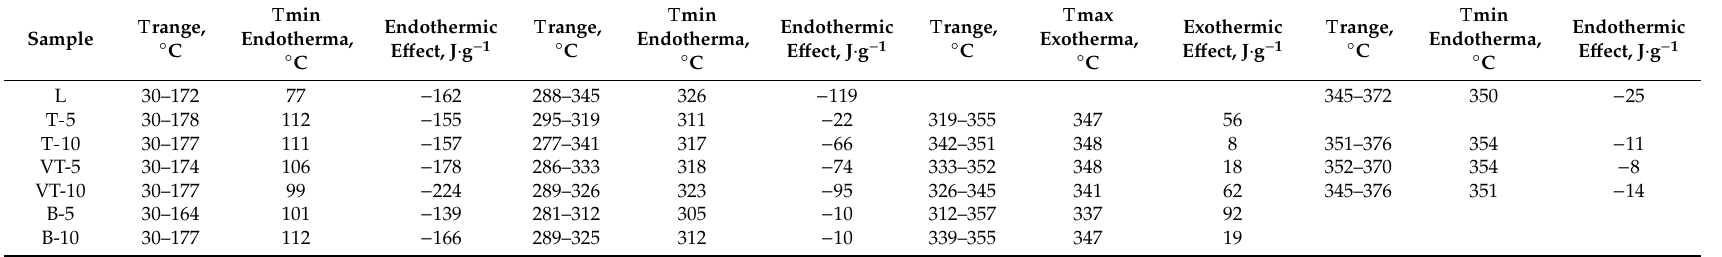
Table 5. The main parameters of fibers obtained by DSC studies at a heating rate of 10 K / min in an inert atmosphere.